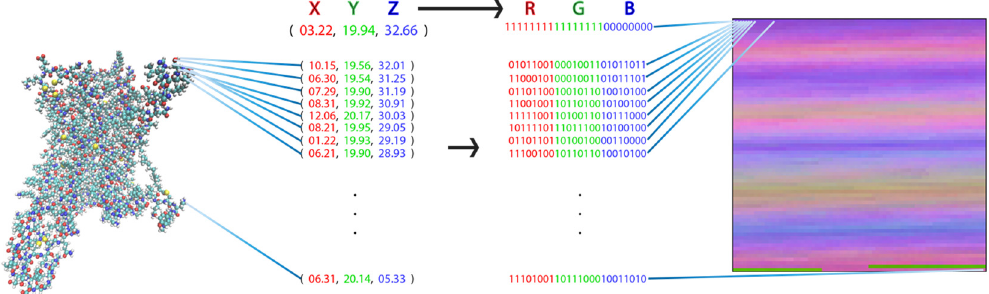
Figure 1. Visual representation of a molecular structure. Each atom of the molecule (left) is identified by the set of (X,Y,Z) coordinates as illustrated by the numerical set. The transformation to a 2D picture-like representation is obtained by assignment to each pixel representing an atom (in sequential order from top left to bottom right) by a pixel whose red, green, blue (RGB) value is the XYZ coordinate of the atom it represents (identified by the set of digital values). This representation has the special property that each pixel (i.e., matrix element) always represents the same atom in each frame from the trajectory of a particular protein.